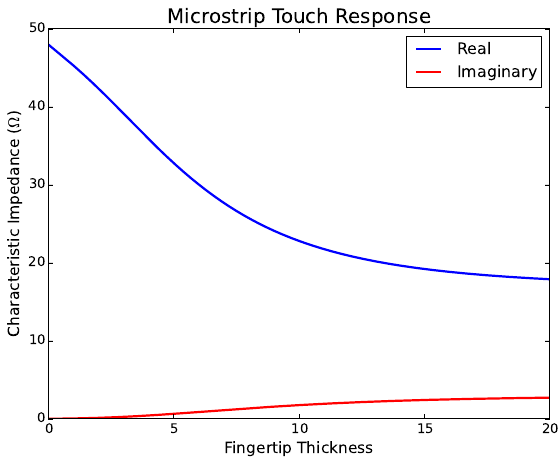
Figure 10. Effect of touch on the characteristic impedance of a microstrip